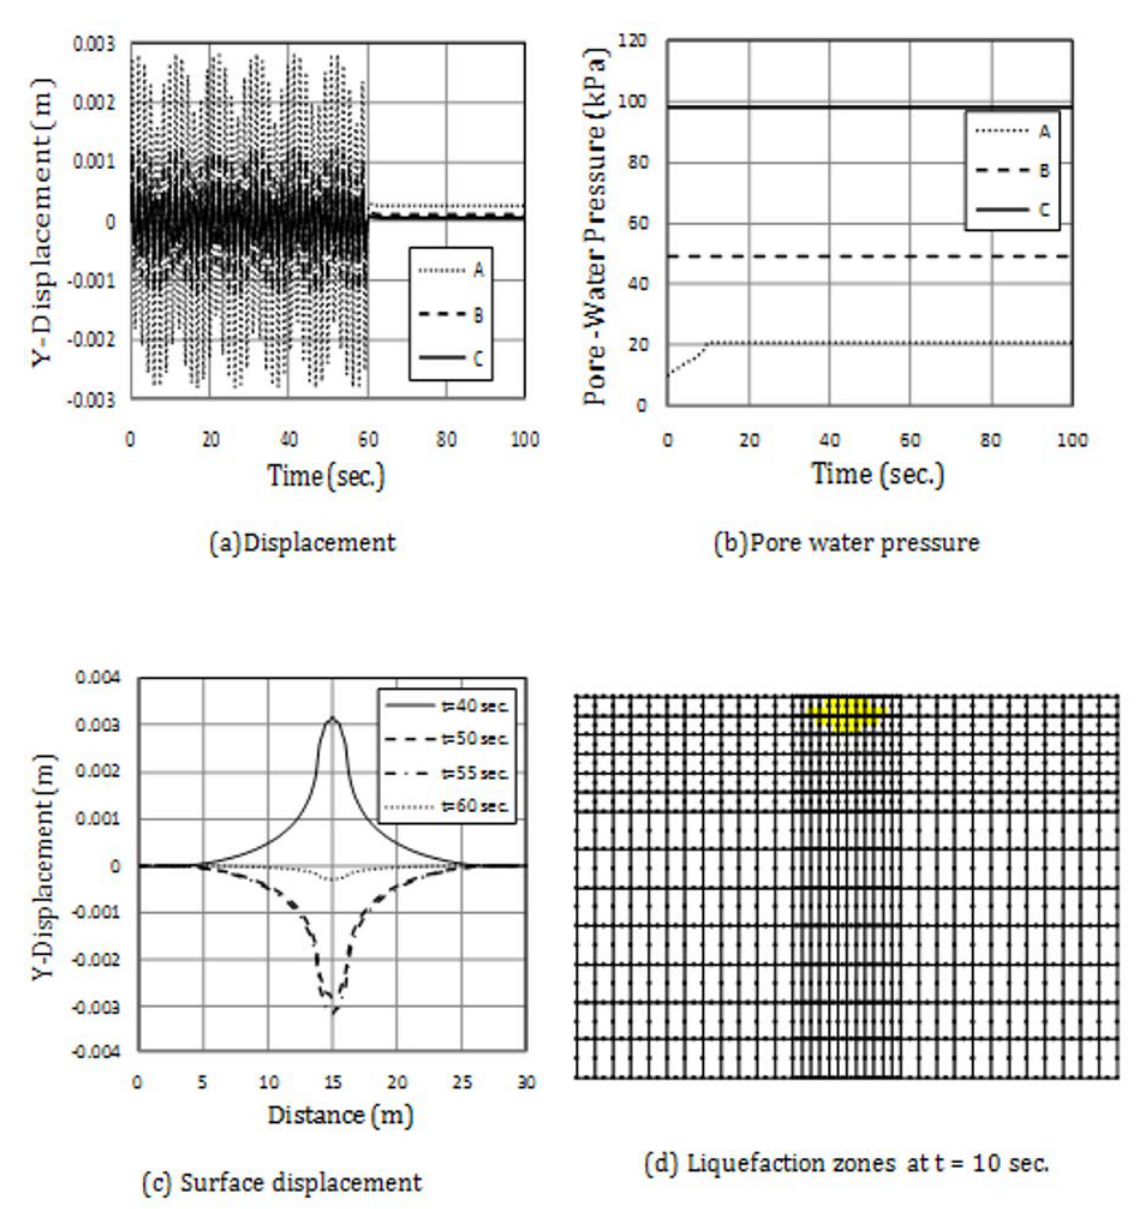
Figure 15. Dynamic response of the foundation to harmonic load, a